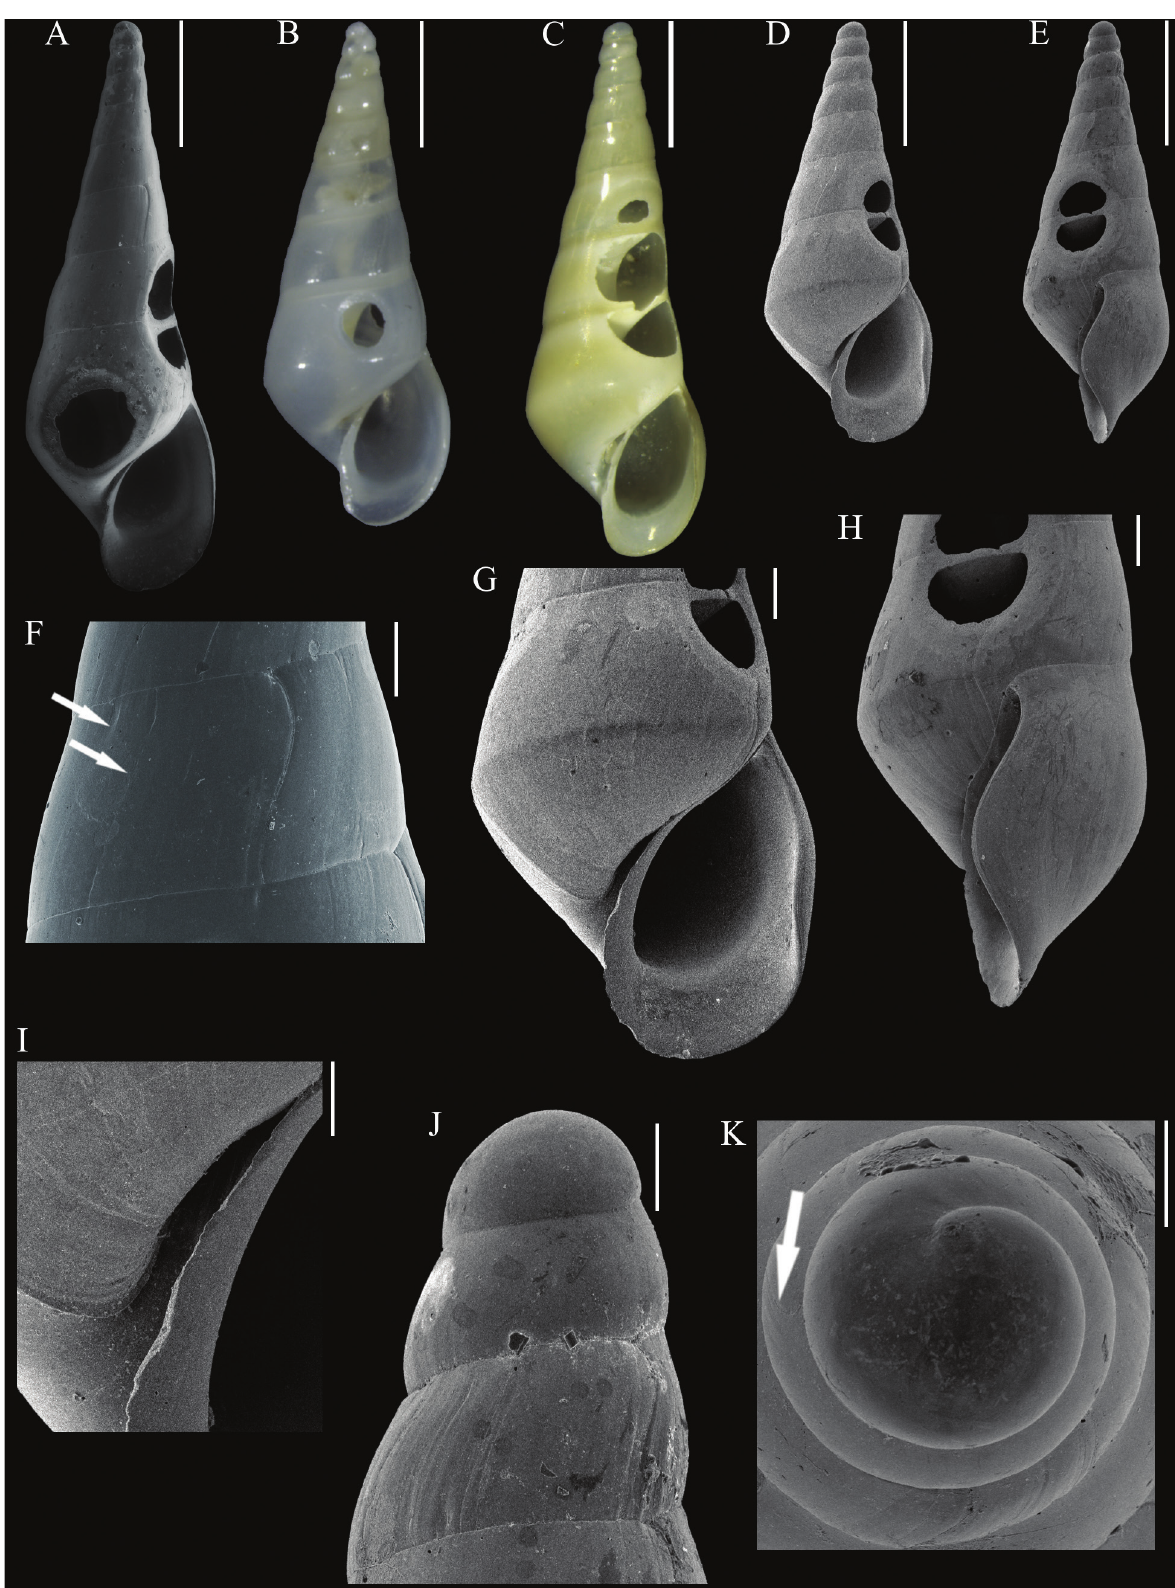
Figure 4. Eulimacrostoma patula (Dall & Simpson, 1901), comb. nov. A. Lectotype herein designated (USNM 160202); B, F. (MNRJ 34479); C. ( MNRJ 34476). D–E, G–K. (MNRJ 34589). A–D. Shell in frontal view; E. Shell in lateral view; F. Detail of teleoconch surface, white arrows indicates microsculpture of axial lines; G. Detail of body whorl in ventral view; H. detail of body whorl in lat- eral view; I. Detail of umbilical fissure; J. Detail of apical whorls in frontal view; K. Detail of protoconch in apical view, white arrow indicates the transition from protoconch to teleoconch. Scale bars: 1 mm (A–E); 200 µm (F–H); 100 µm (I–K). Credits: A: